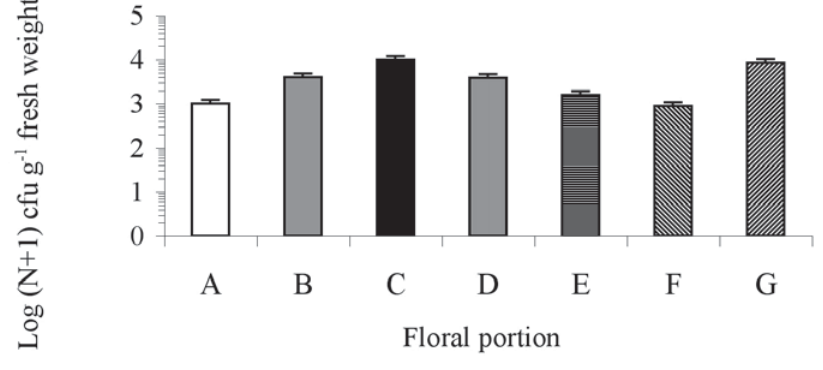
Fig. 1. Epiphytic bacterial populations on gerbera cv. Provence portions after cutting on day 0. A, scape basal por- tion; B, portion at 30 cm; C, portion at 20 cm; D, portion below the capitulum; E, sepals; F, petals; G, capitulum. Data represent the mean (±SD) of 10